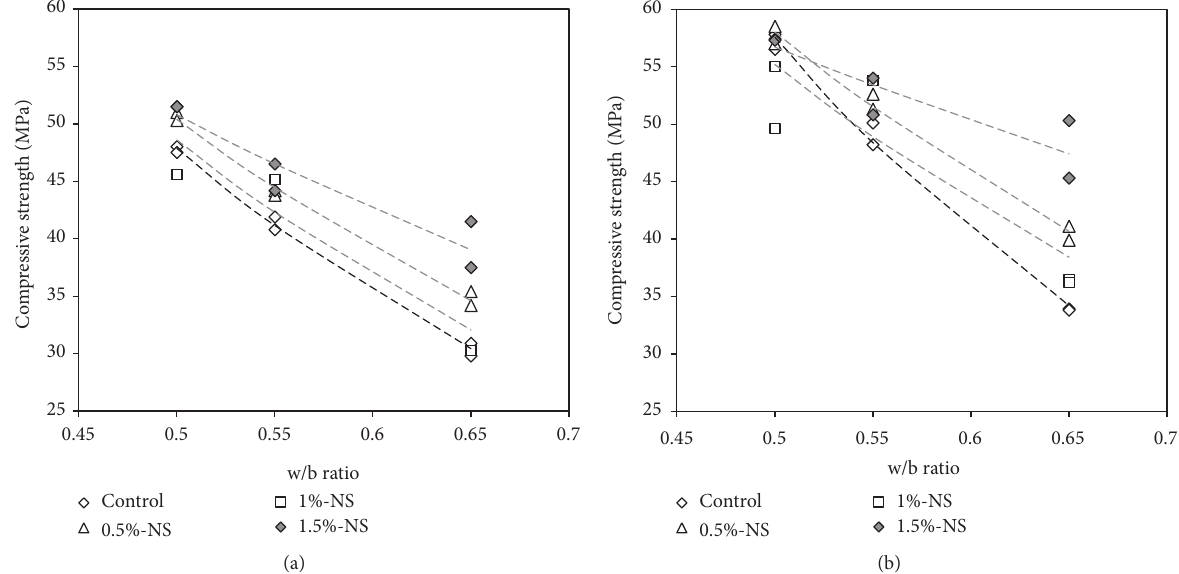
Figure13:Compressivestrengthofconcreteasafunctionofw/bratio:(a)7daysand(b)28daysofcuring.Dashedlinesrepresentinterpolated values according to Abram’s law. The black line represents reference